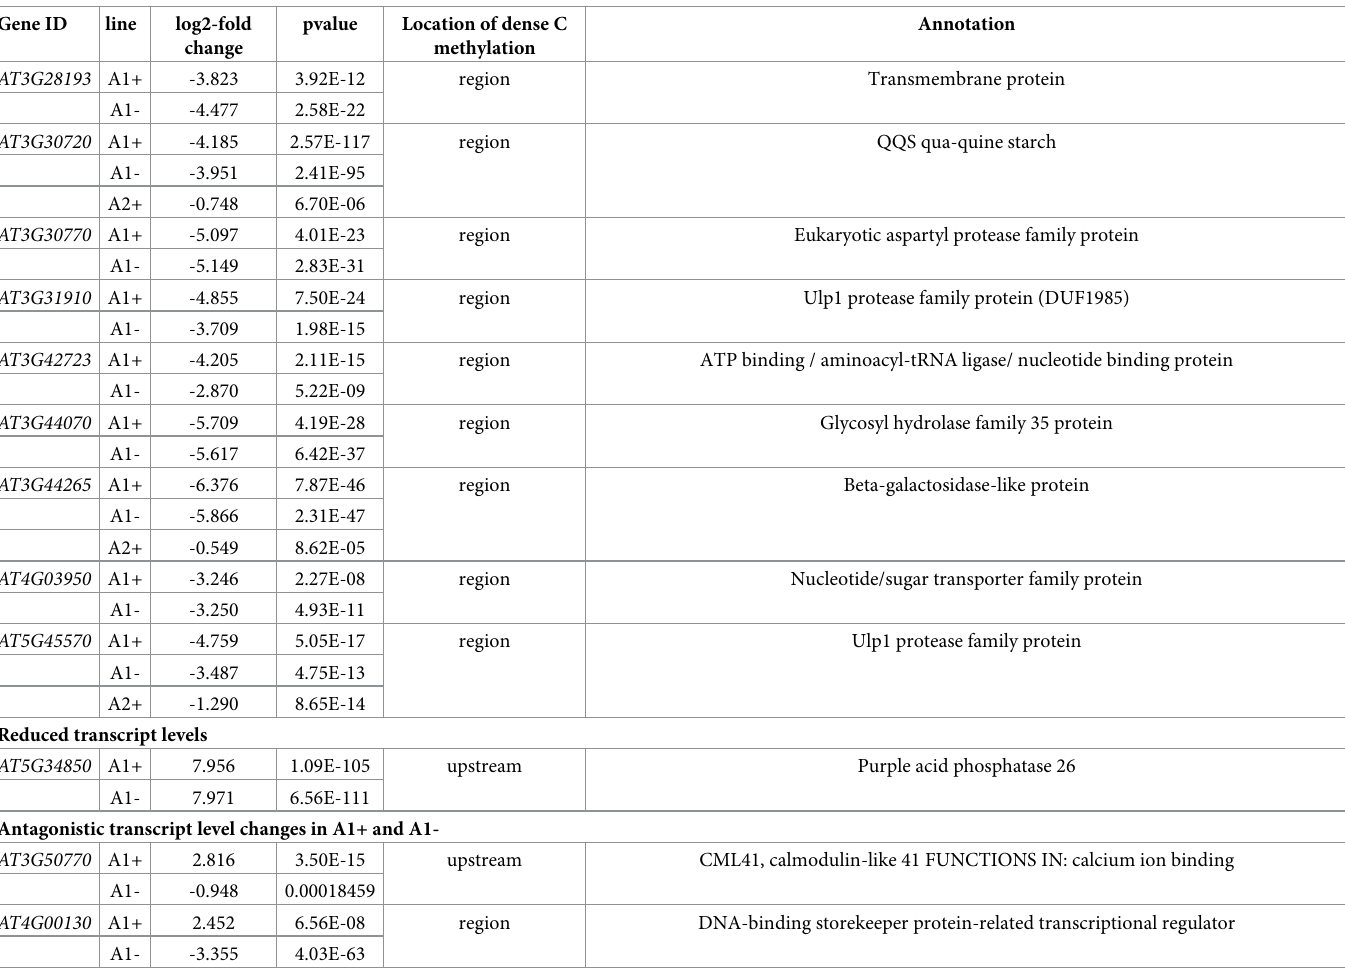
and in the RNA-DEPENDENT RNA POLYMERASE 2 mutant rdr2 . QQS expression levels, ylation level of repeated sequences located within the 5 0 end of the gene. DNA methylation and expression variants can be inherited for several generations.